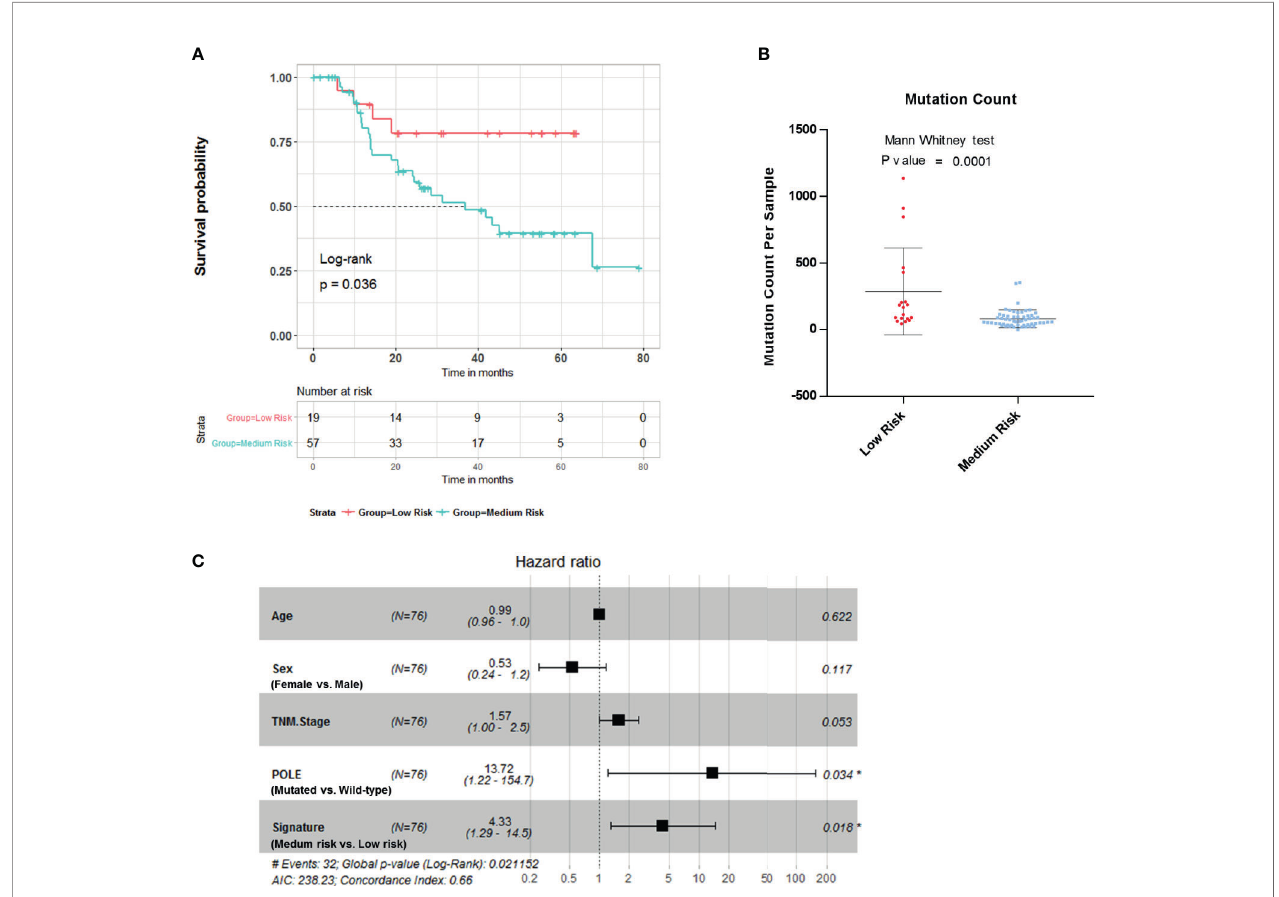
FIGURE 4 | Validation of the risk score in Tianjin gastric adenocarcinoma cohort. (A) Kaplan – Meier survival analysis strati fi ed by risk score. (B) Mutation count per sample of gastric adenocarcinoma strati fi ed by risk score. (C) Multivariable Cox regression model tests for age, sex, TNM stage, polymerase ϵ (POLE) mutation status, and 4-gene mutation score. *p <